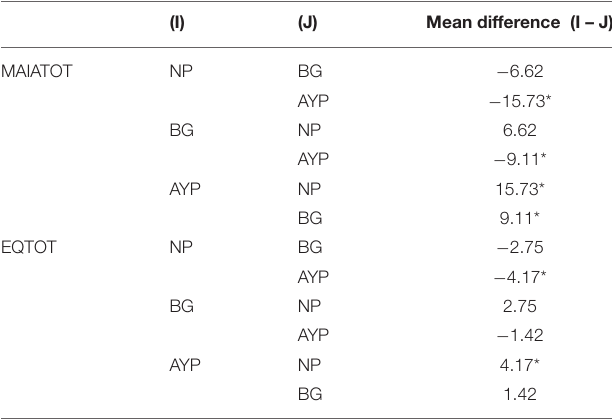
TABLE 6 | Multiple comparisons between groups based on yoga practice in total MAIA and EQ-D scores in the Indian participants.